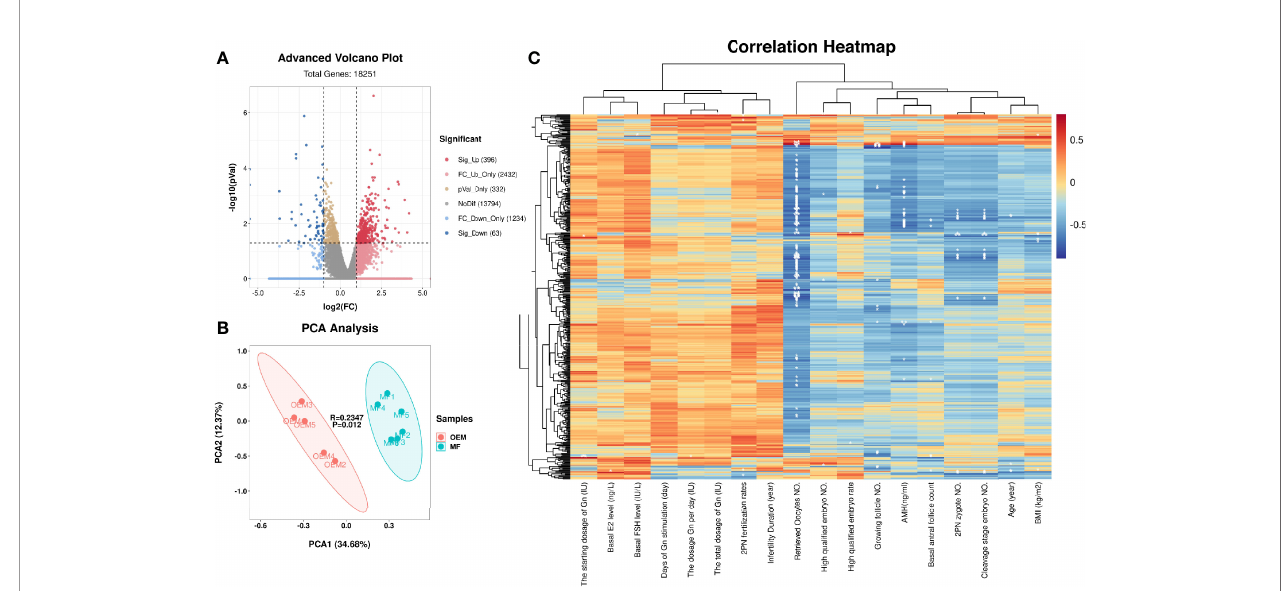
FIGURE 1 | mRNA pro fi ling of granulosa cells (GCs) from patients with infertility associated with ovarian endometriosis (OEM). (A) The x-axis of the volcano map represents log 2 (fold change (FC)) value of total detected genes, while the y-axis represents their − log 10 ( p value) value. The signi fi cant FC_up differentially expressed genes (DEGs) are presented in the upper right quadrant (red), and the signi fi cant FC_down DEGs are shown in upper left quadrant (blue). (B) Two-dimensional principal component analysis (PCA) of DEGs from the transcriptomes of RNA-seq data. The PC1 separates the two groups (MF versus OEM). The PC2 separates the samples according to the gene expression pattern. Green color indicates samples from the male factor (MF) group, and red color indicates samples from the OEM group. (C) Correlation heatmap between DEGs and the clinical characteristics of RNA-seq GC samples. The ordinate represents DEGs, and the abscissa is clinical characteristics (* p < 0.05, ** p < 0.01, *** p < 0.001) ( N MF = 6, N OEM =